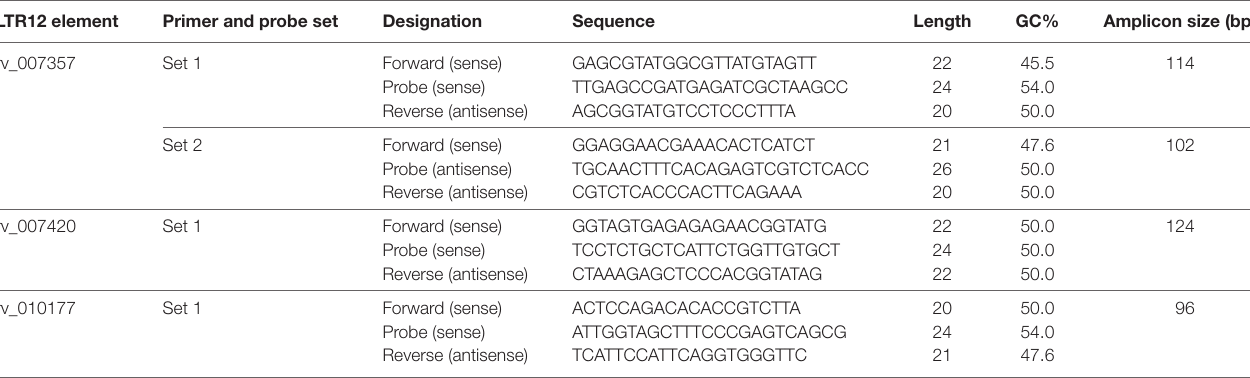
Table 1 | Custom TaqMan assays used to confirm the upregulation of LTR12 elements by vorinostat treatment. a lTr12 element